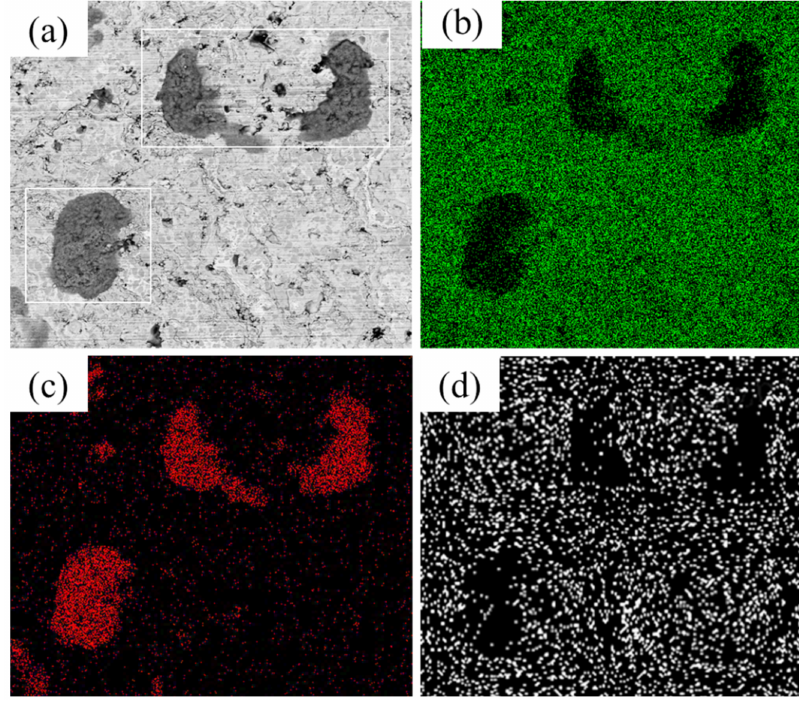
Figure 13. ( a ) The corrosive surface of No. 1 suffered BFT and ( b – d ) Mapping EDS of Cr, Fe and Ni